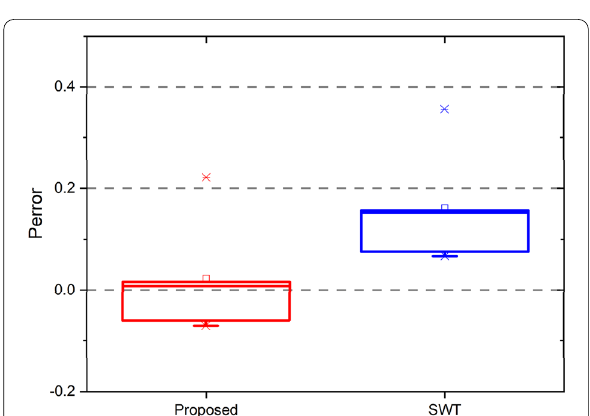
Figure 14 Prediction error of GCr15 under contact